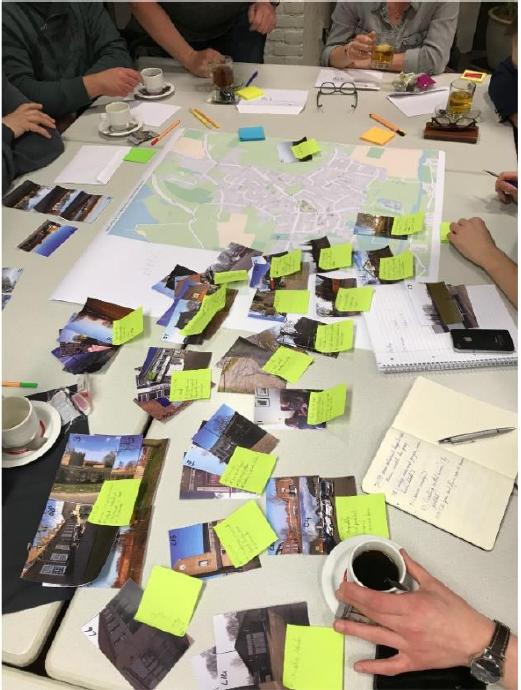
Figure 1. Photovoice. Source: own image.